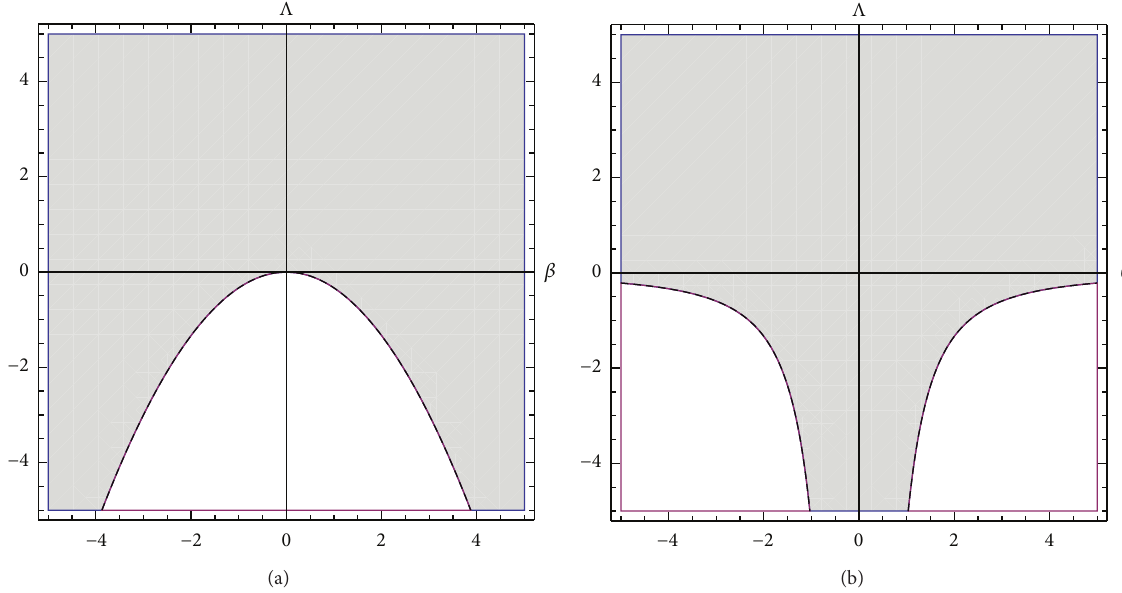
Figure 3: The grey area of the first plot corresponds to 𝑓 > 0 . The grey area in the second plot corresponds to 𝑔 > 0 . The white region in both plots corresponds to the negative values of 𝑓 and 𝑔 .